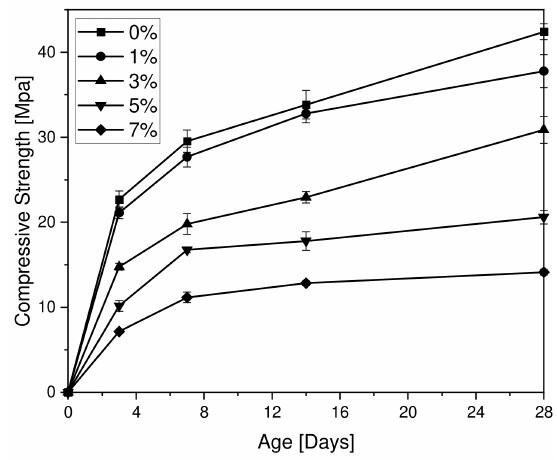
Figure 11. Compressive strength of alkali-treated BSC.